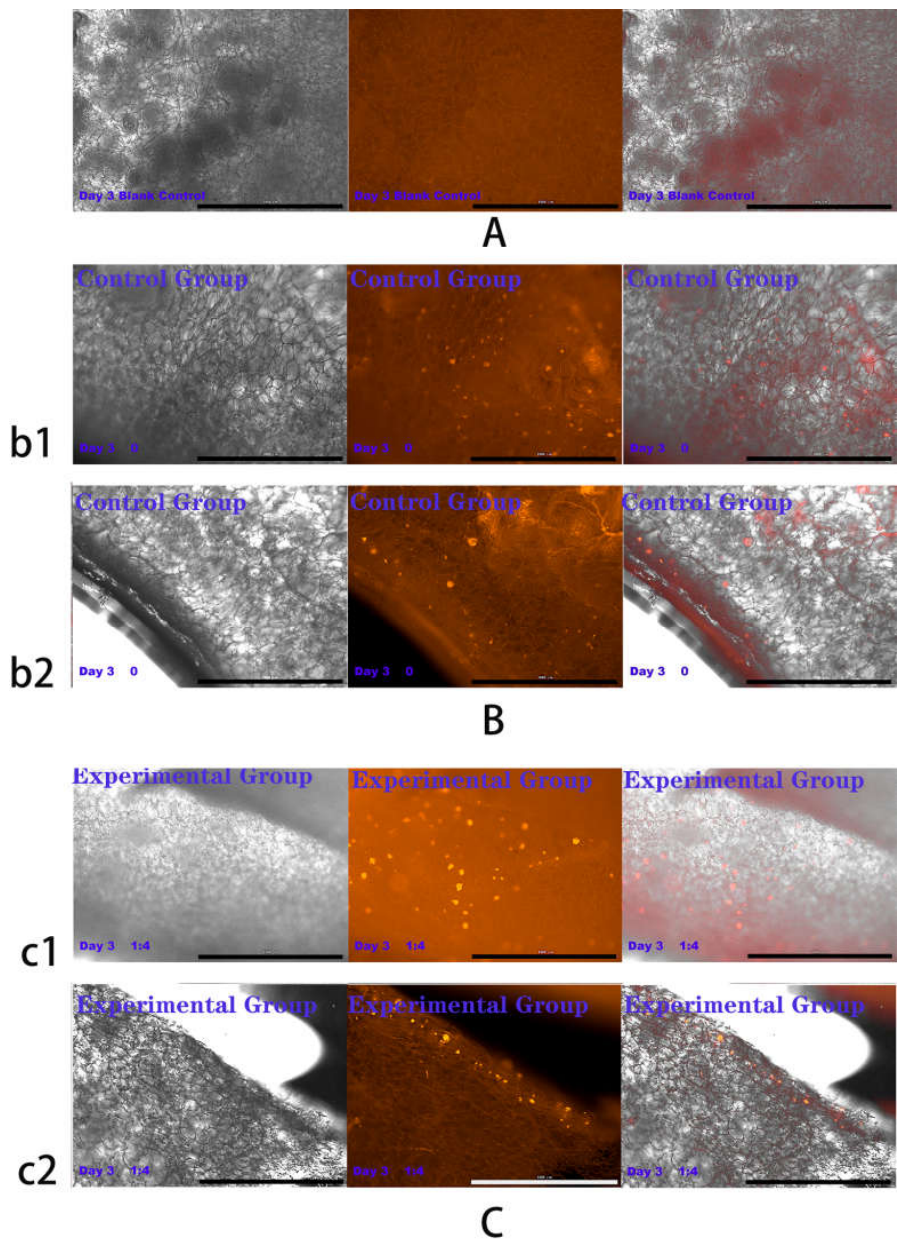
Figure 13. Cells were co-cultured for 3 days. Growth of HSFs labeled with amino graphene quantum dots on tissue engineering scaffolds. b1 and c1 and are fluorescence maps of HSFs growing on the surface of tissue engineering scaffolds. b2 and c2 are fluorescence maps of HSFs growing on the cross section of the tissue engineering scaffolds. ( A ) Blank group, ( B ) control group, ( C ) is experimental group. From left to right are the bright field diagram, the fluorescent field diagram, and the sum diagram of the bright field and the fluorescent field. Scale bar: 1000 μm.